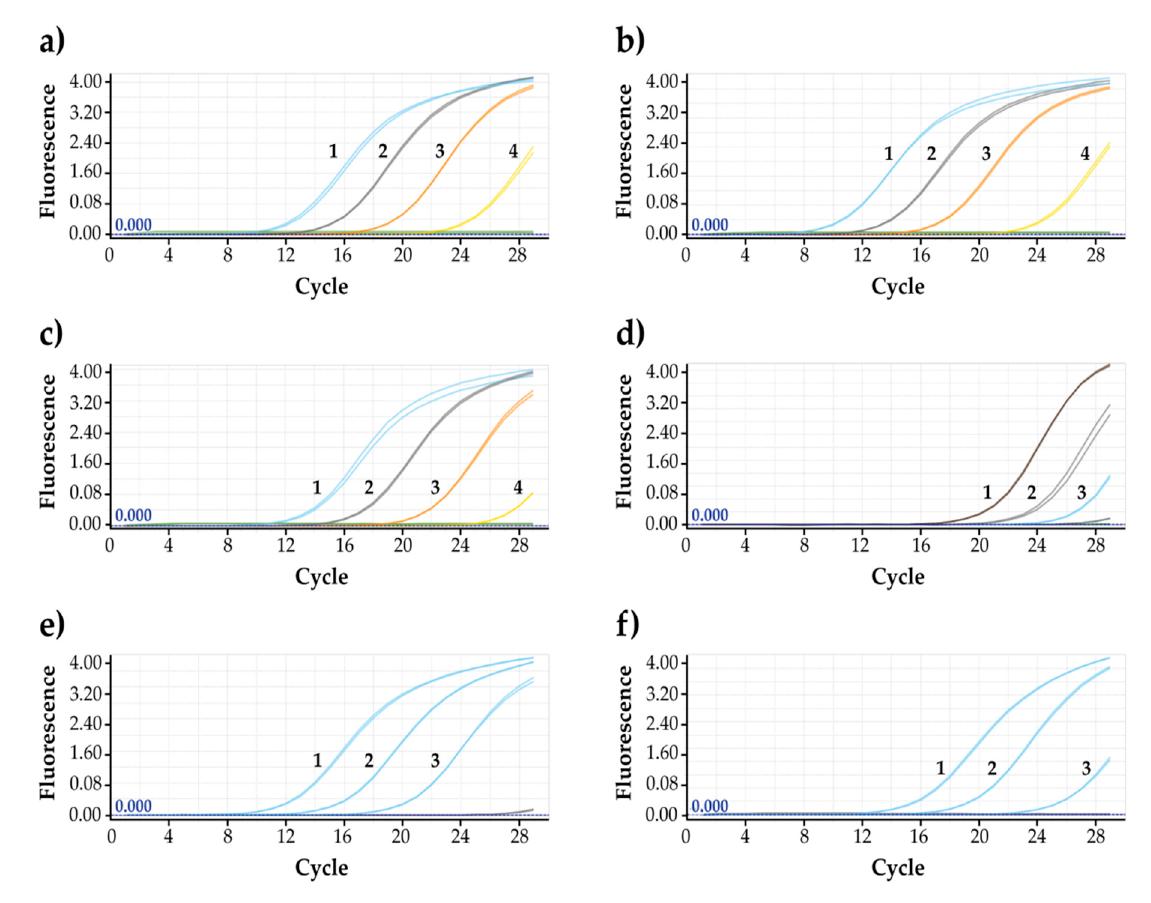
Figure 7. Sensitivity of the designed primers for three Chironex species (amplification curves). ( a ) 16S rRNA gene for Chironex Sp.A. ( b ) 16S rRNA gene for Chironex indrasaksajiae . ( c ) 16S rRNA gene for Chironex Sp.C. ( d ) COI gene for Chironex Sp.A. ( e ) COI gene for Chironex indrasaksajiae . ( f ) COI gene for Chironex Sp.C. 1: 10 ng; 2: 1 ng; 3: 0.1 ng; 4: and 0.01 ng (DNA template concentrations).